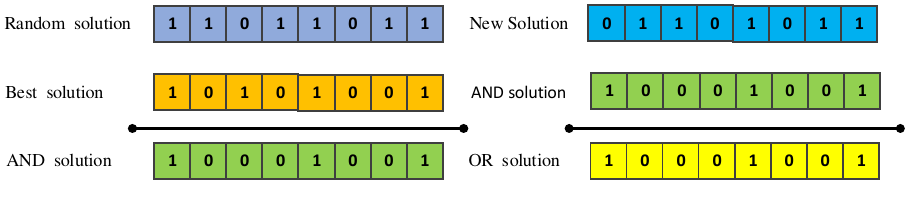
Figure 2. Bitwise